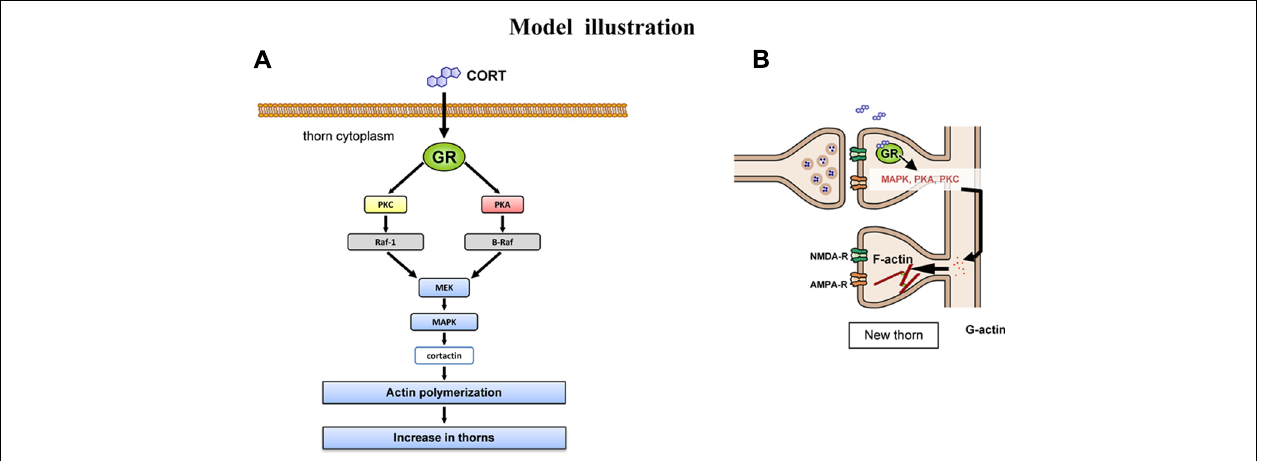
phosphorylation of actin-related proteins such as cortactin, resulting in actin reorganization. (B) Schematic illustration of CORT-induced rapid thorn-genesis via multiple kinase